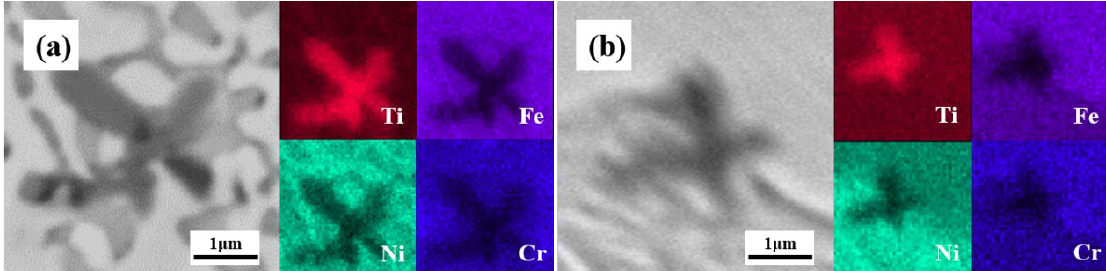
Figure 7. SEM images and EDS map scanning results of the petal-like precipitates: ( a ) 60Ni-40Ti; ( b ) 55NiTi-5Ni.